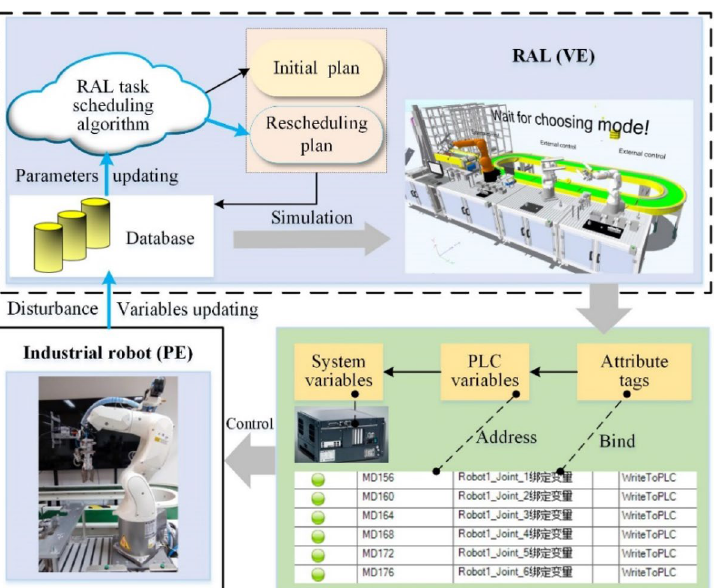
Figure 6. VE-PE control mechanism.